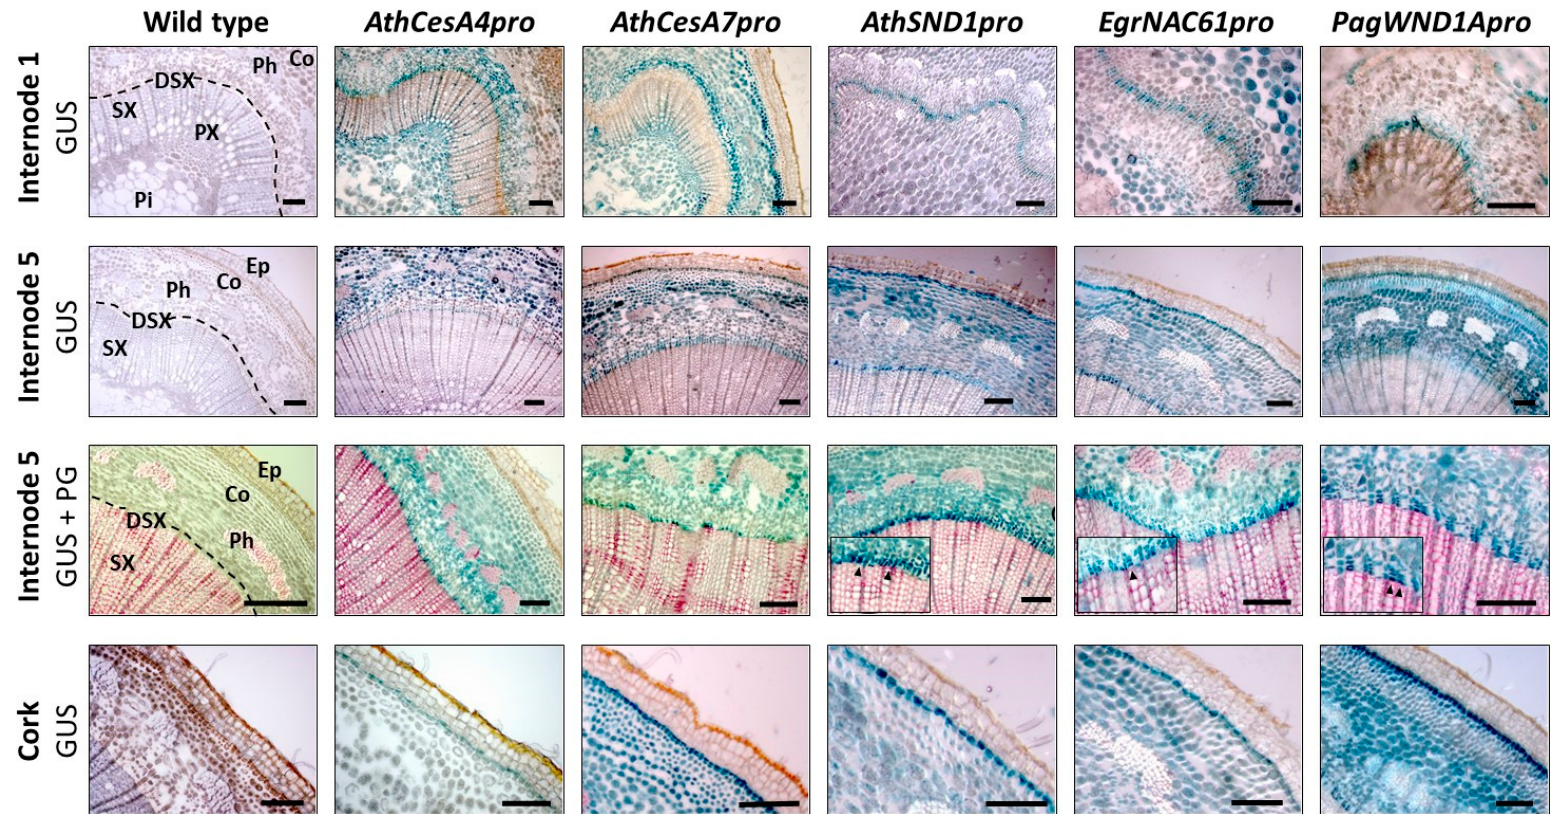
Figure 3. Histochemical analysis of transgenic Populus tremula × P. alba stems . Blue staining indicates β -glucuronidase (GUS) expression patterns, while phloroglucinol (PG) staining marks lignified cells in pink. The dashed line marks the approximate position of the vascular cambium. Inset images show higher magnification of GUS expression in developing xylem, where arrows indicate GUS expression in developing vessels. Ep, epidermis; Co, cortex; DSX, developing secondary xylem; Ph, phloem; Pi, pith; PX, primary xylem; SX, secondary xylem. Scale bar = 100 µm.